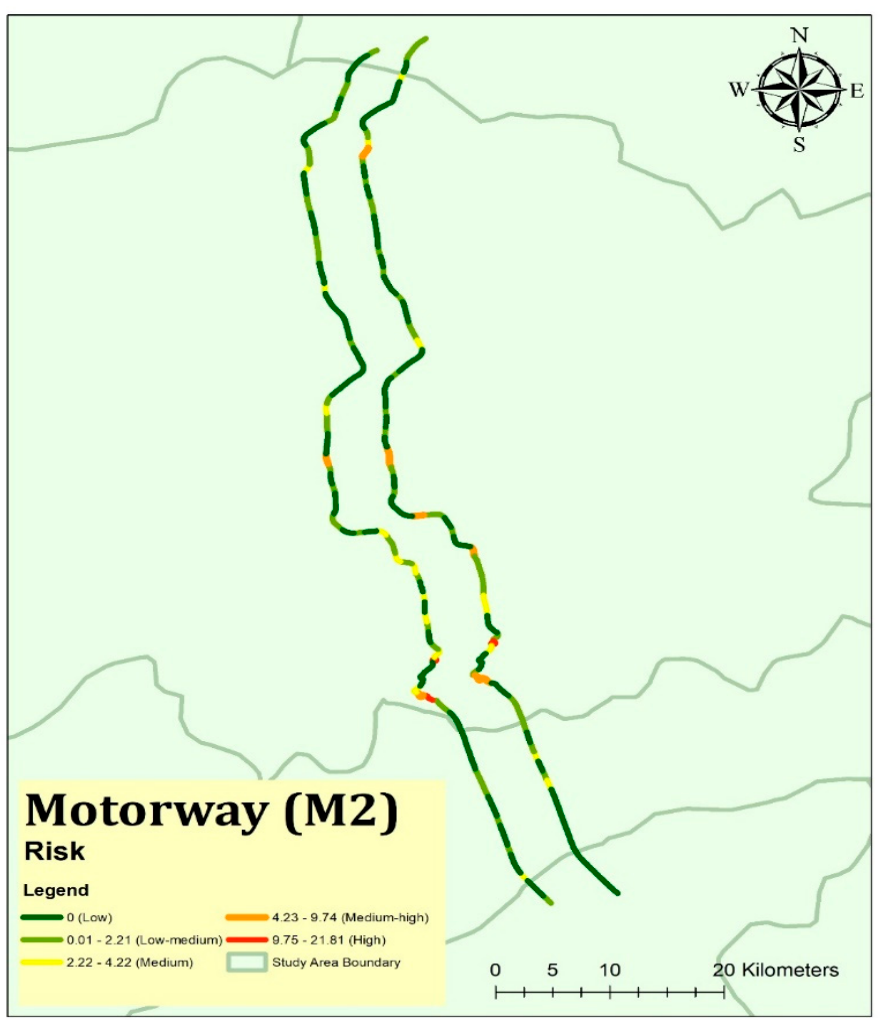
Figure 6. Risk map of motorway (M-2).